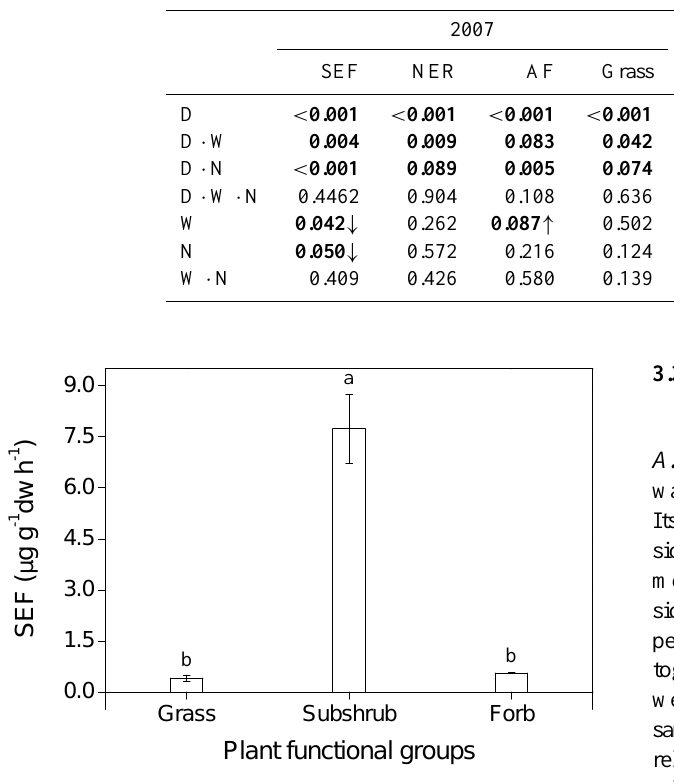
Fig. 4. Standard monoterpene emission factor (SEF, mean ± 1SE) for different plant functional groups incubated in syringe. Differ- ent letters up the column indicate significant difference ( P < 0 . 05) among the plant functional groups ( Artemisia frigida is the only subshrub